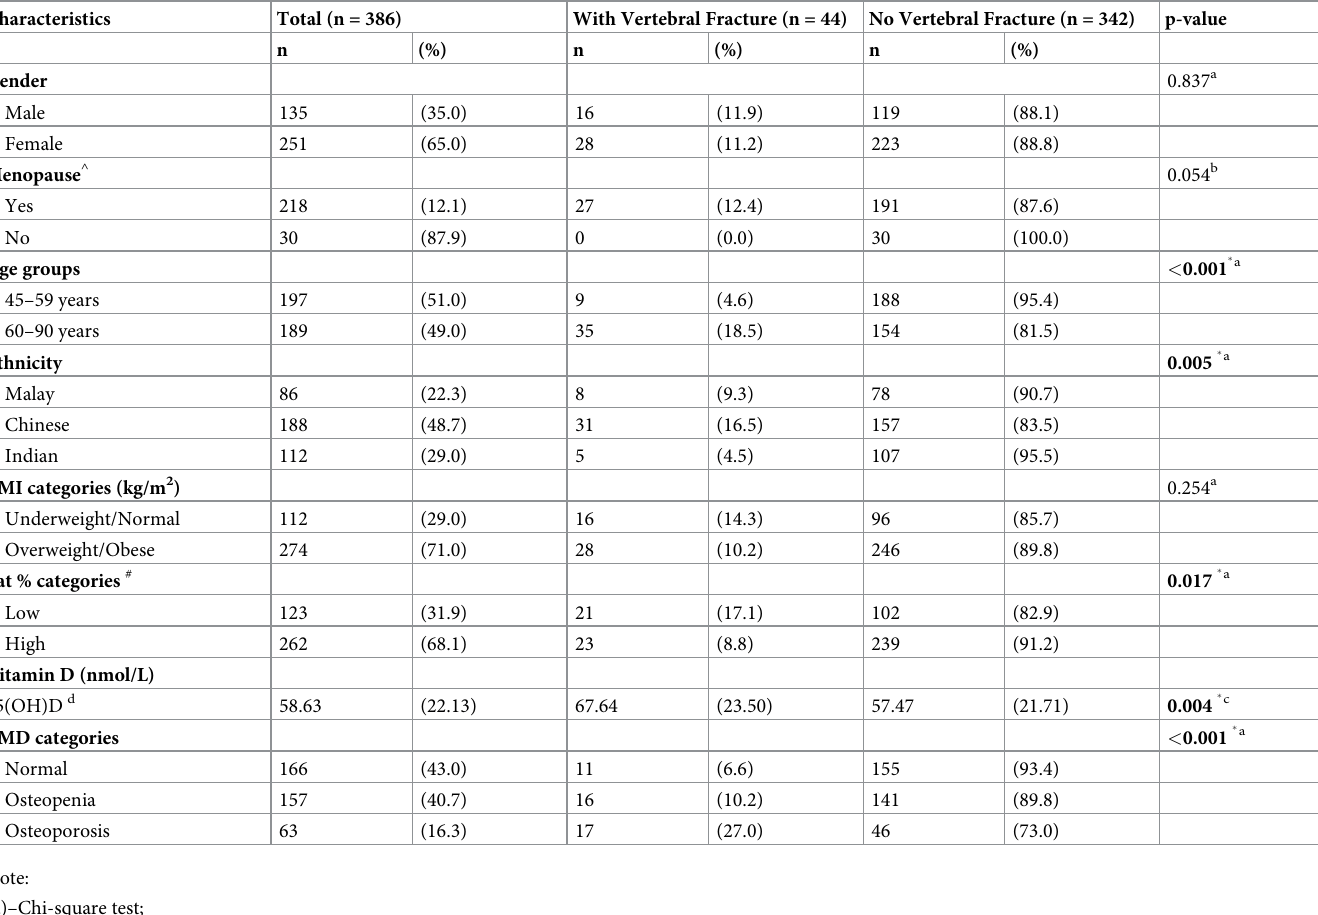
Table 1. Characteristics of the subjects and association of variables with vertebral